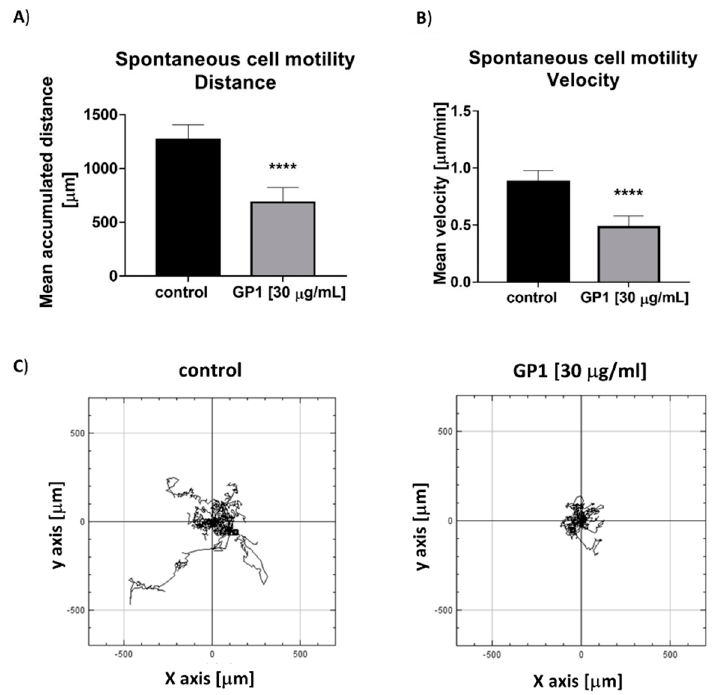
Figure 8. Mean accumulated distance ( A ) and mean velocity ( B ) of GP1-treated cells and controls over the course of 24 h. Statistical significance was evaluated with an Unpaired t -test. **** significantly different from controls, p < 0.0001. Graphical representation of spontaneous cell motility using the Chemotaxis Tool, representative result from one of the measurements ( C ).